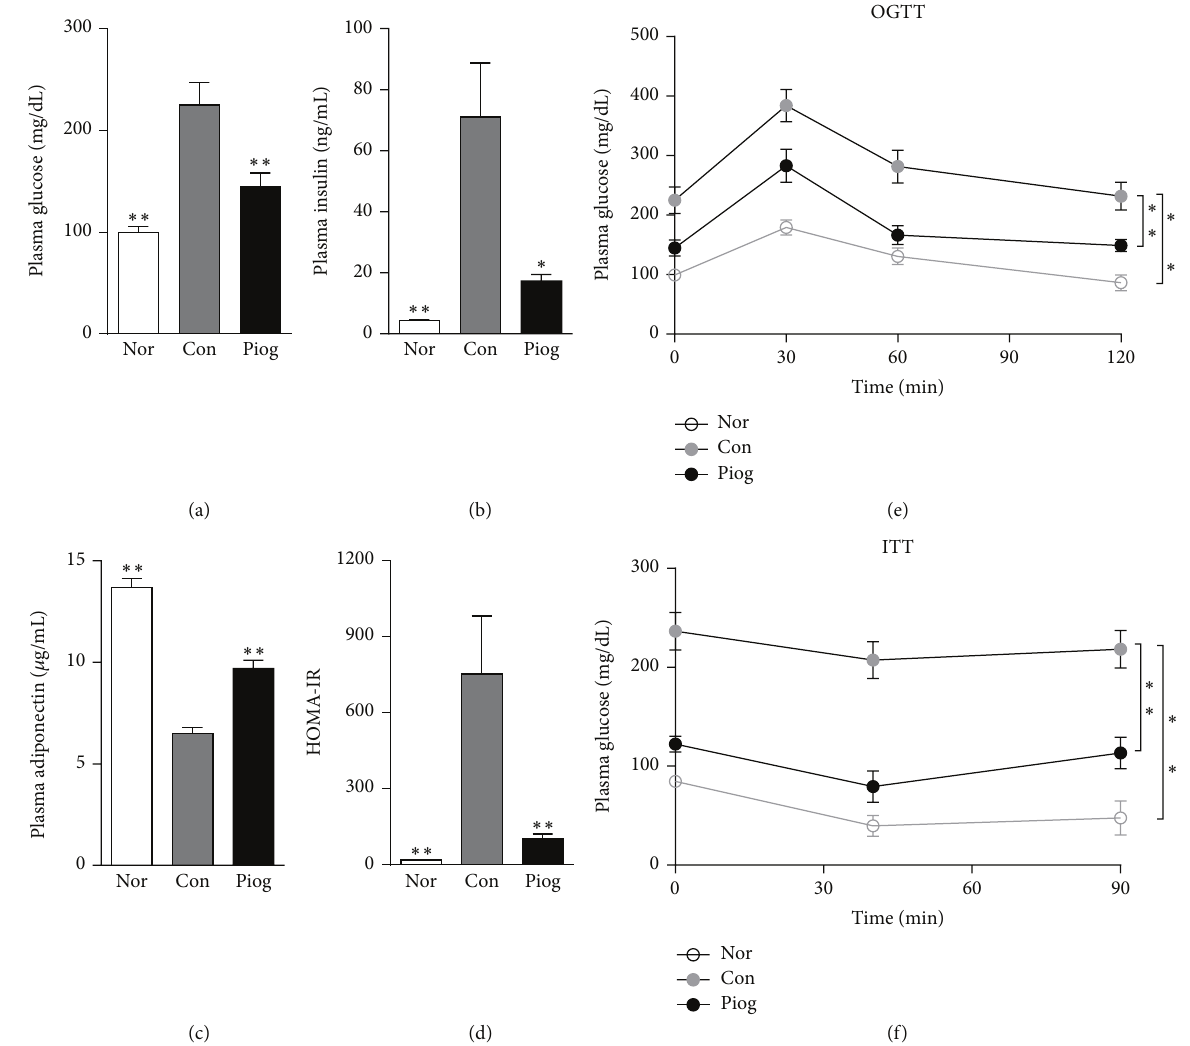
Figure 1: Pioglitazone ameliorated systemic insulin resistance in diabetic KKAy mice. Fasting plasma glucose (a), insulin (b), and adiponectin (c) were measured at the end of the treatment. HOMA-IR (d) was calculated by (FPG (mg/dL) × FINS (ng/mL))/22.5. OGTT (e) and ITT (f) were performed in fasted animals on days 21 and 25 of treatment, respectively, as described in Section 2. Nor, C57BL/6J mice; Con, vehicle- treated KKAy mice; Piog, pioglitazone-treated KKAy mice. Data are presented as mean ± S.E.M. ( 𝑛 = 10 per group). ∗ 𝑃 < 0.05 , ∗∗ 𝑃 < 0.01 versus